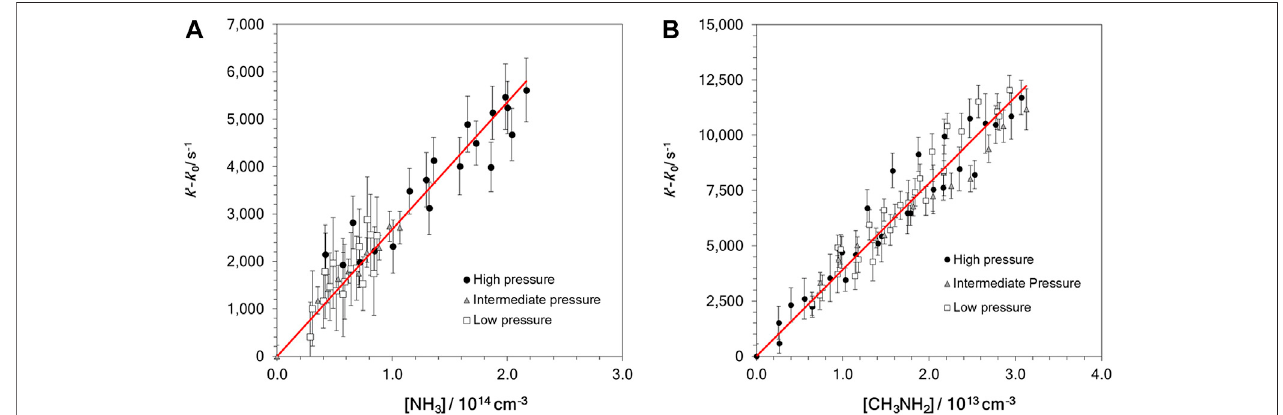
FIGURE 3 | Bimolecular plots for the OH-reactions at ca. 22 K with (A) NH 3 and (B) CH 3 NH 2 .